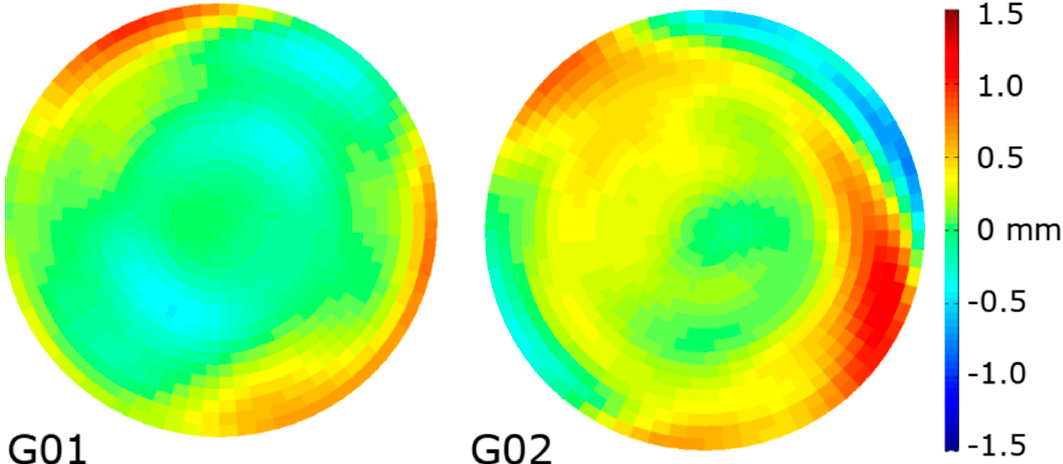
Figure 4. PCV variations between ATX08 and ATX14 for two GPS signal frequencies for the TRM57971.00 NONE antenna.